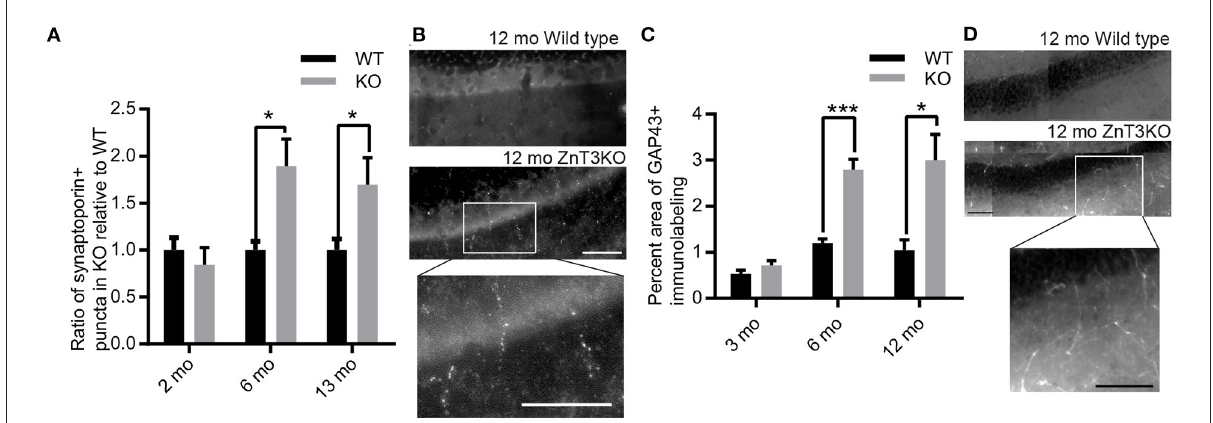
FIGURE6 Aberrant, age-dependent mossy fiber sprouting in ZnT3KO hippocampus. (A) Quantification of synaptoporin puncta shows an age-dependent increase in mossy sprouting in the molecular layer of the dentate gyrus in ZnT3KO hippocampus. (B) Representative image of synaptoporin immunolabeling quantified in A and magnification of KO inset box. (C) Quantification of the percent area of GAP43 immunolabeling in the molecular layer of the dentate gyrus shows an age-dependent increase in ZnT3KO hippocampus. (D) Representative image of GAP43 immunolabeling quantified in C and magnification of KO inset box. WT, wild type; KO, ZnT3KO; synaptoporin, 6 mo. n = 10, 13 mo. WT n = 8, KO n = 11; scale bars 100 µ m; * p < 0.05, *** p < 0.0002; three fields from each subject were imaged at 63X, puncta counted by an experimenter blinded to subject conditions and values expressed as fold change relative to WT puncta for each subject; GAP43, n = 5; ten fields from each subject were imaged at 63X, quantified using the Axiovision (Zeiss) automated measurement program and the average percent area calculated. Data were analyzed by two-tailed unpaired t -test. Error bars indicate the mean ± SEM.